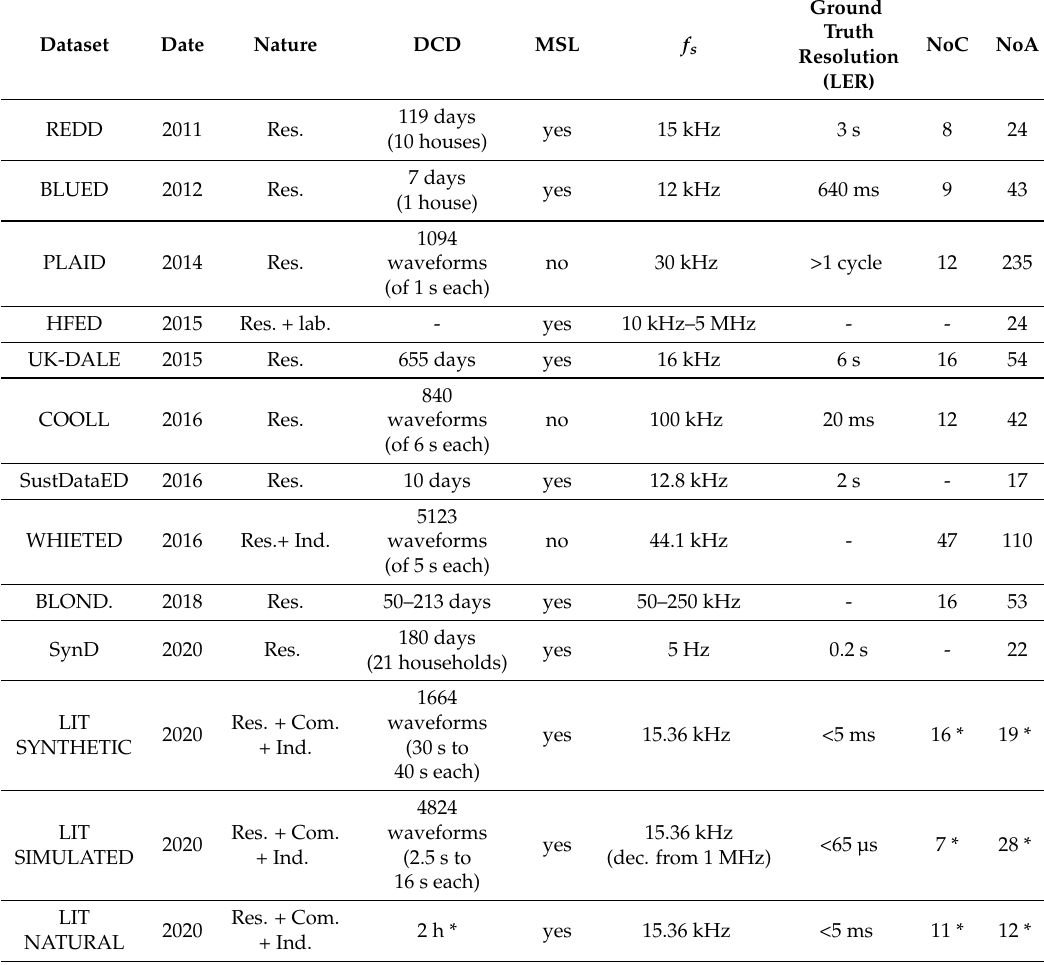
Table 17. Comparison of high-frequency NILM